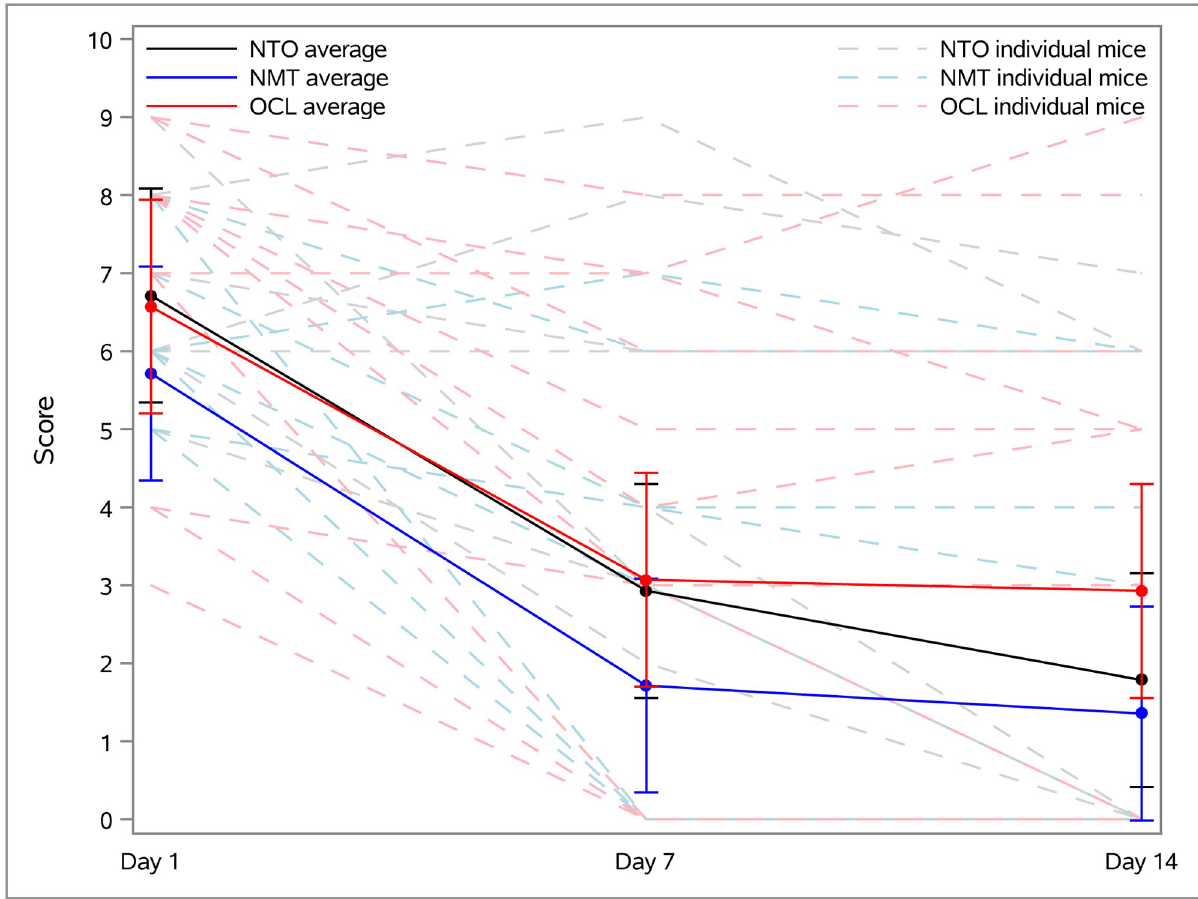
Fig 4. UD score change over time. UD score changes over study timepoints. The solid lines (NTO in black; NMT in blue; OCL in red) show the treatment mean scores while the broken lighter lines show individual animal scores. Data are presented as treatment mean ± standard error of the mean